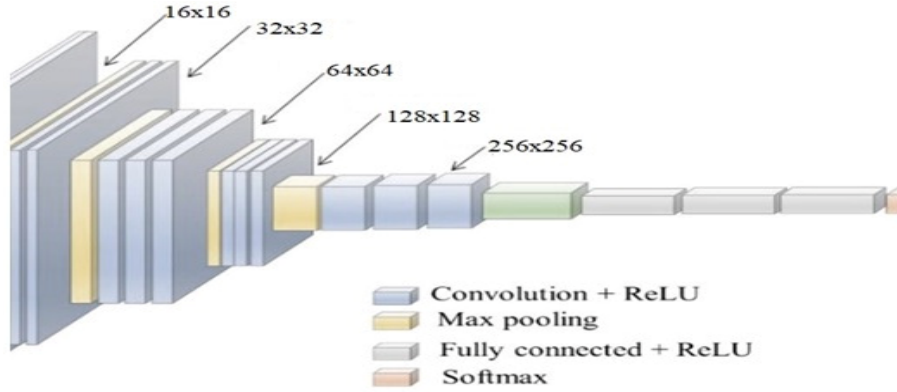
Figure 6. A typical CNN model used for classification of spinal cord regions.